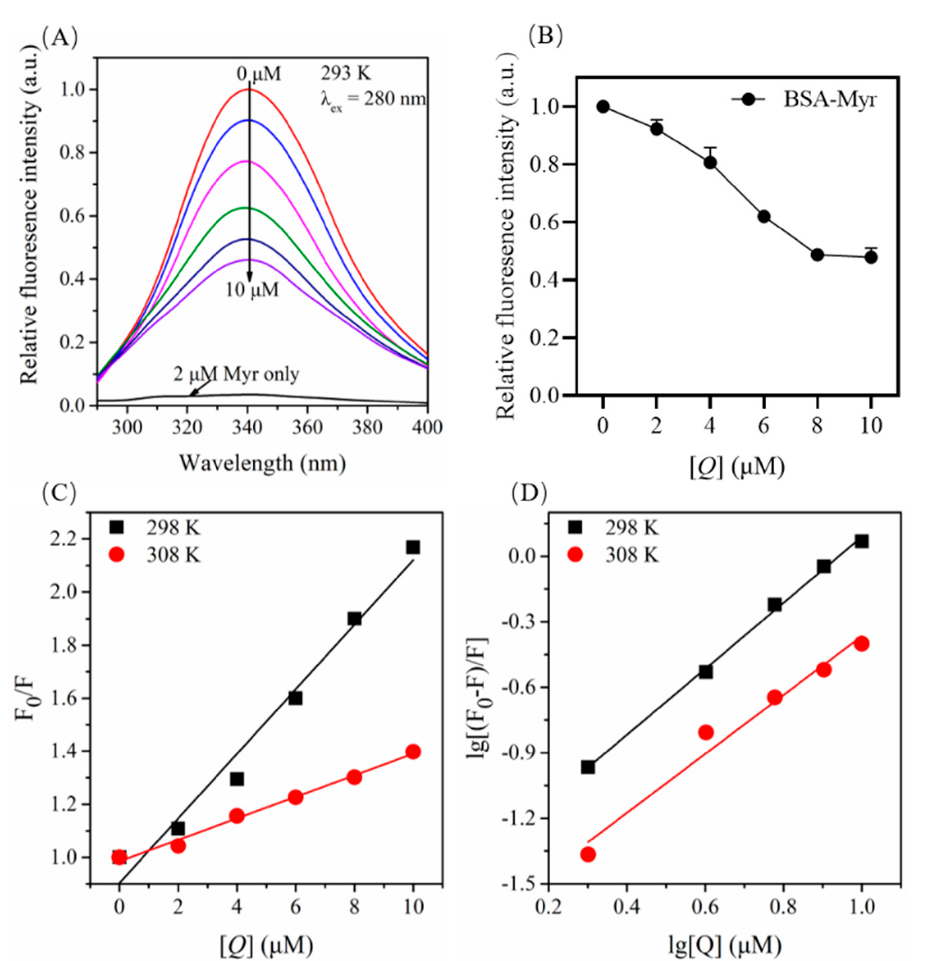
Figure 4. Fluorescence emission spectra of Myr-BSA system in 10 mM PBS (pH = 7.4) at 293 K. ( A ) Fluorescence emission spectra for BSA (2 µ M) with Myr (0, 2, 4, 6, 8, 10 µ M). ( B ) The fluorescence intensity of BSA at 340 nm in absence and presence of Myr (0–10 µ M). ( C ) The Stern - Volmer plots of fluorescence quenching constant ( K q ) for the Myr-BSA complexes at different temperatures. ( D ) The double logarithmic plots at different temperatures.